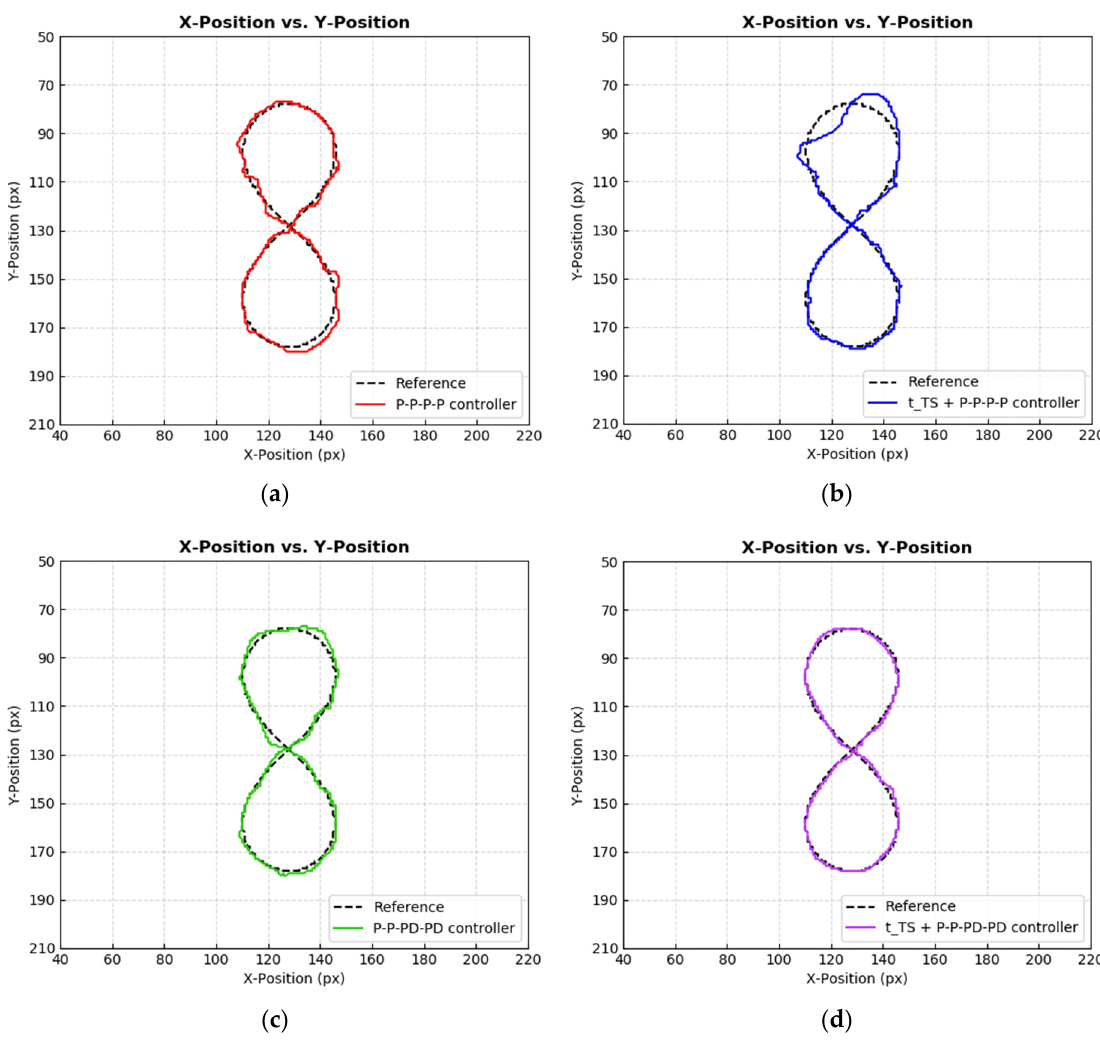
Figure 21. 8-shaped trajectory tracking performance by ( a ) P–P–P–P controller, ( b ) t TS + P–P–P–P controller, ( c ) P–P–PD–PD controller, and ( d ) t TS + P–P–PD–PD controller on Cartesian